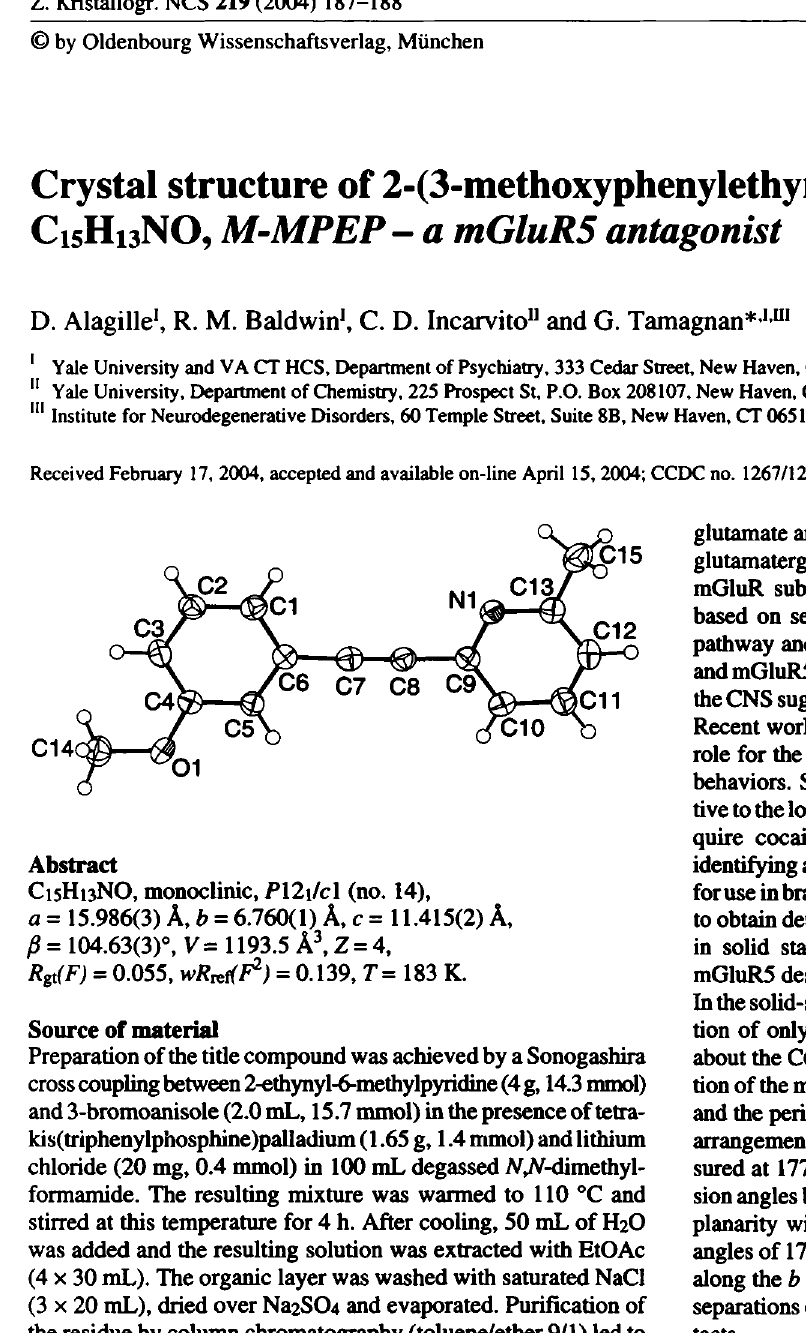
Table 1. Data collection and handling.